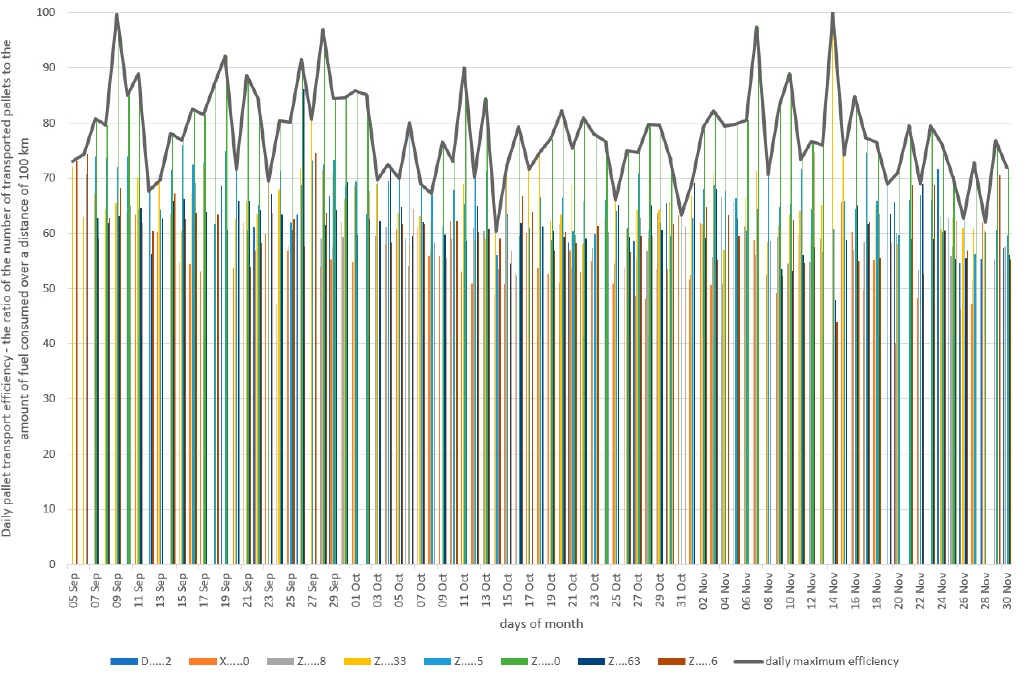
Figure 9. Daily efficiency—the ratio of the number of transported pallets to the amount of fuel consumed over a distance of 100 km, expressed in [%], where the reference is the most effective day in a given 3-month period.